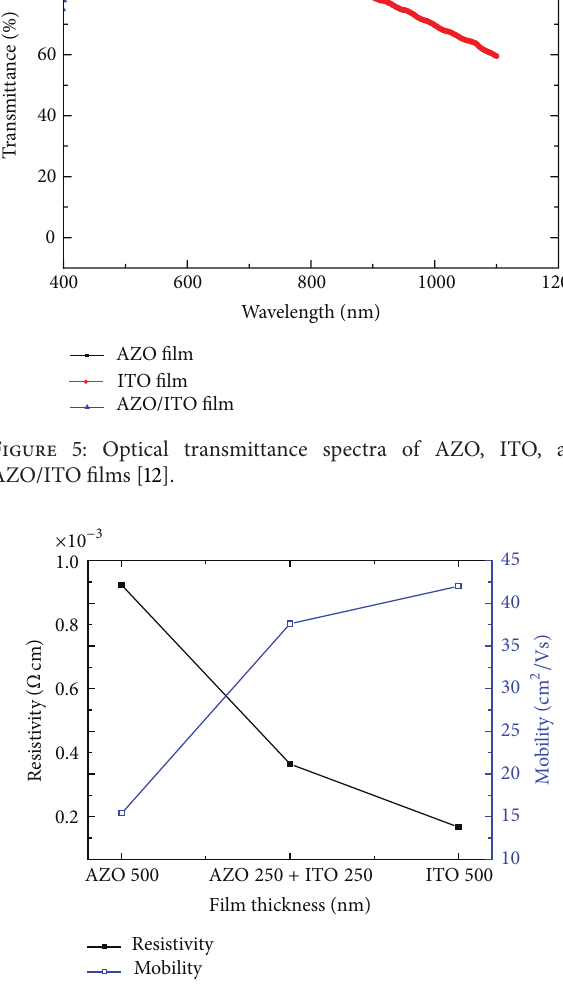
Figure 6: Electrical properties of AZO, AZO/ITO bilayer, and ITO films